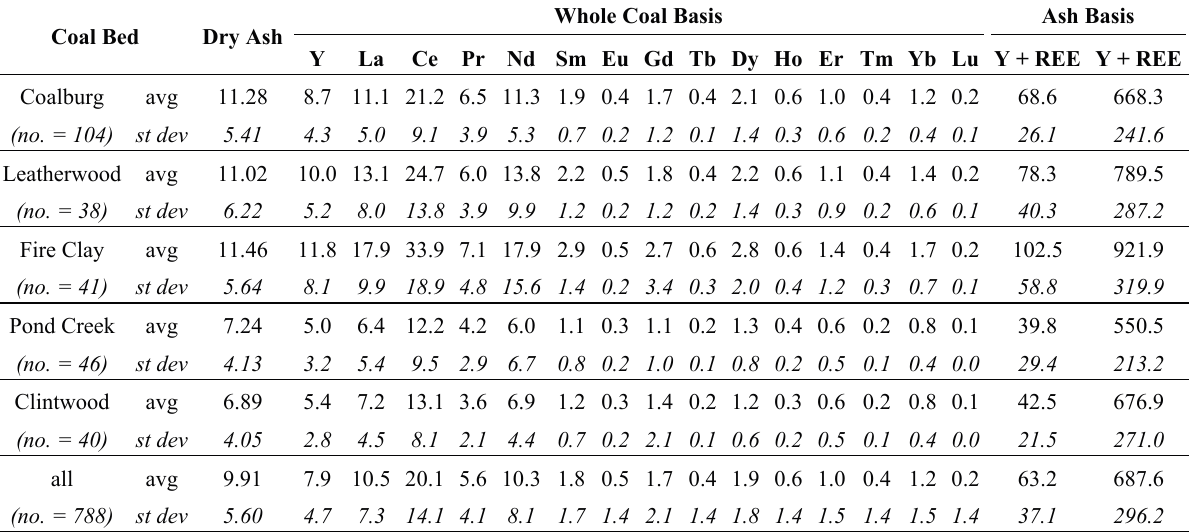
Table 1. Averages (ash-basis ppm) of rare earth elements and yttrium for five major eastern Kentucky coals. Based on data compiled by [4]. The Clintwood Gd average contains one value of 173 ppm, far higher than the other Gd values. Avg: average; st dev: standard